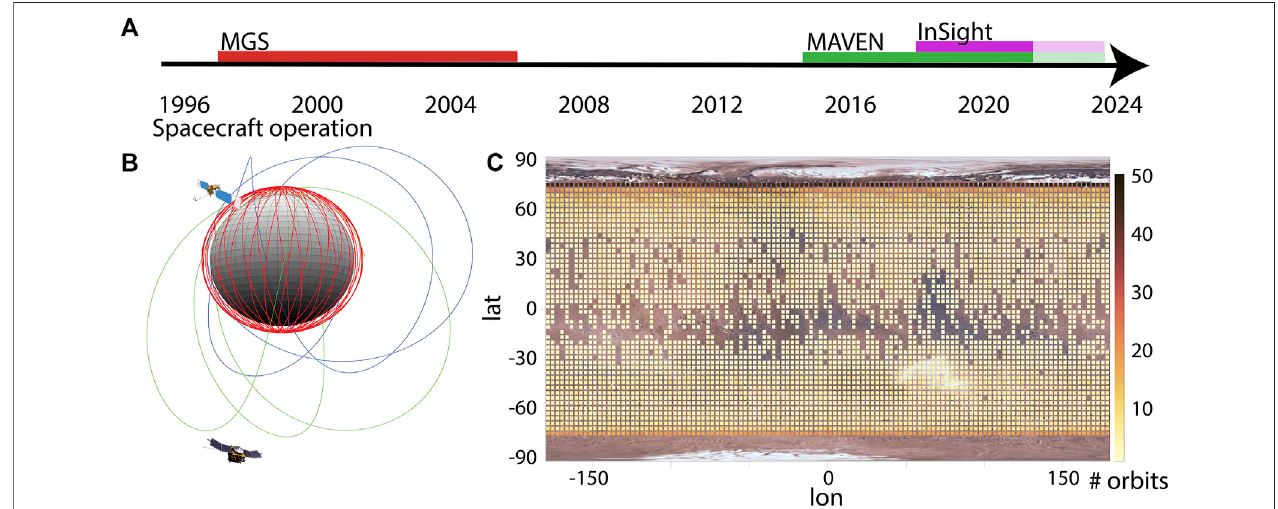
FIGURE 2 | (A) Timeline for missions that have returned information on Mars ’ crustal magnetic fi eld. (B) Representative orbits for MGS (red) and MAVEN (green, blue) (C) MAVEN data coverage at altitudes less than 150 km, for data taken until October 2021. Color scale indicates the number of MAVEN orbits crossing each 3 ° latitude by 3 ° longitude